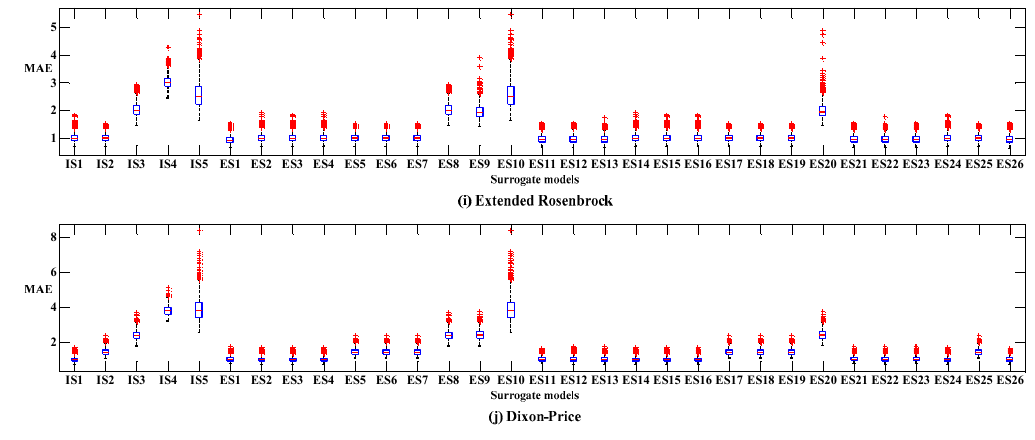
Figure 5. Boxplots of MAE for all test problems.